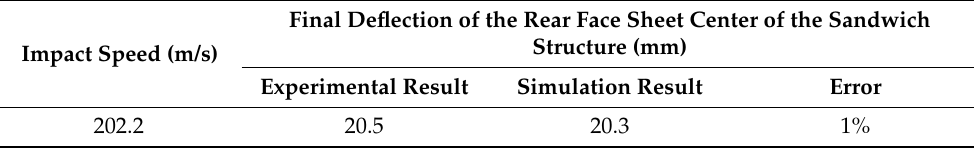
Figure 3. Impact simulation results of the star-shaped honeycomb structure: ( a ) 0 ms; ( b ) 0.25 ms; ( c ) 0.5 ms; ( d ) 5 ms; ( e ) 6 ms. Table 2. Final deflection of the rear face sheet center of the star-shaped sandwich structure.